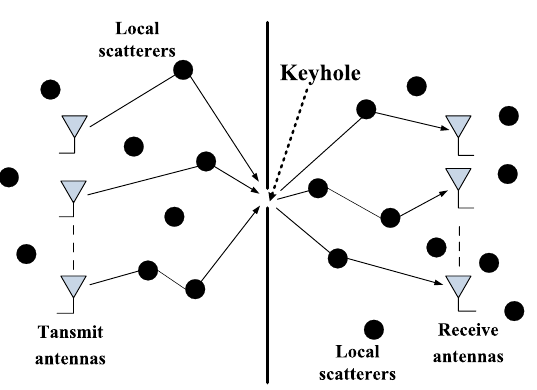
Figure 2. Keyhole effect in MIMO channel